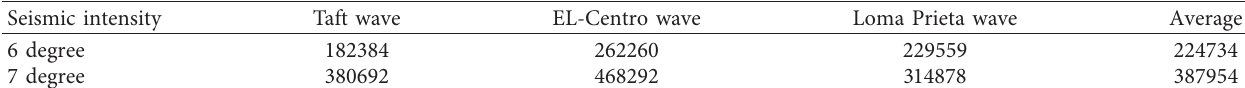
Table 6: Maximum shear stress of wall bottom under each earthquake (Pa).